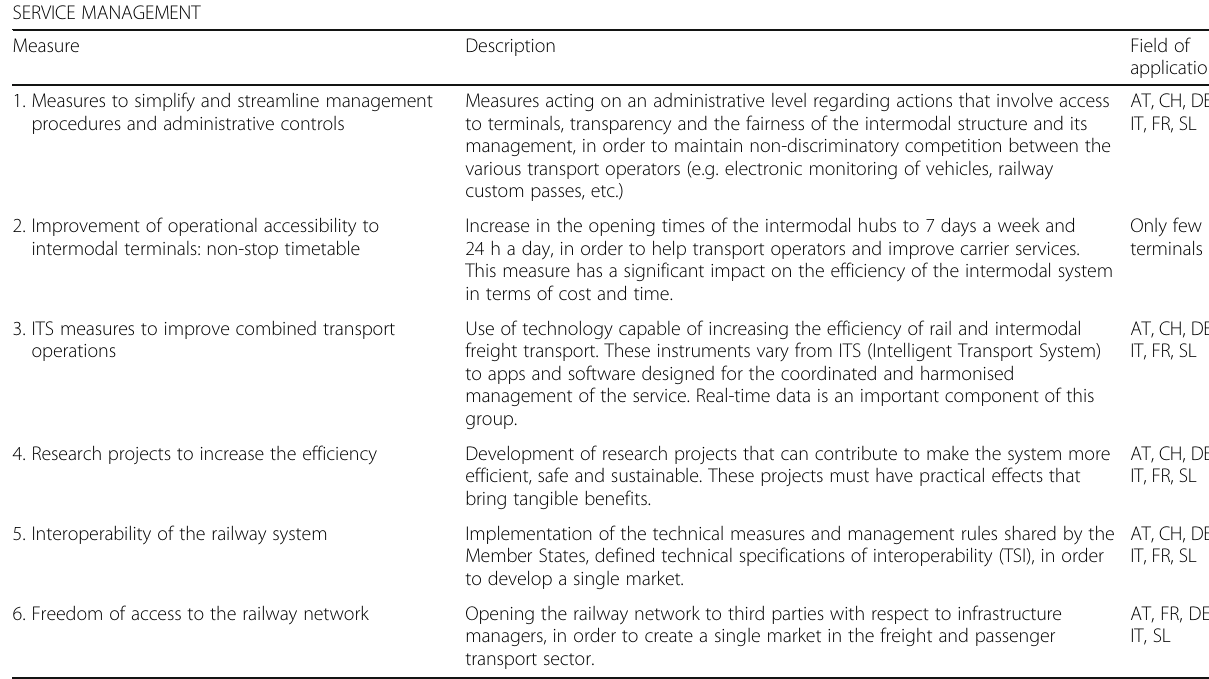
Table 4 List of measures belonging to the “ Service Management ” group SERVICE